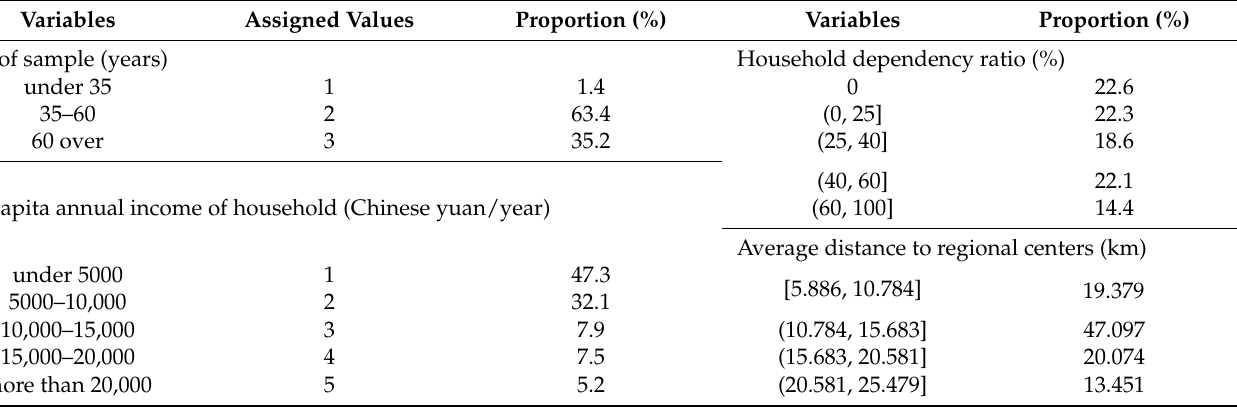
Table 2. Characteristics of the rural households